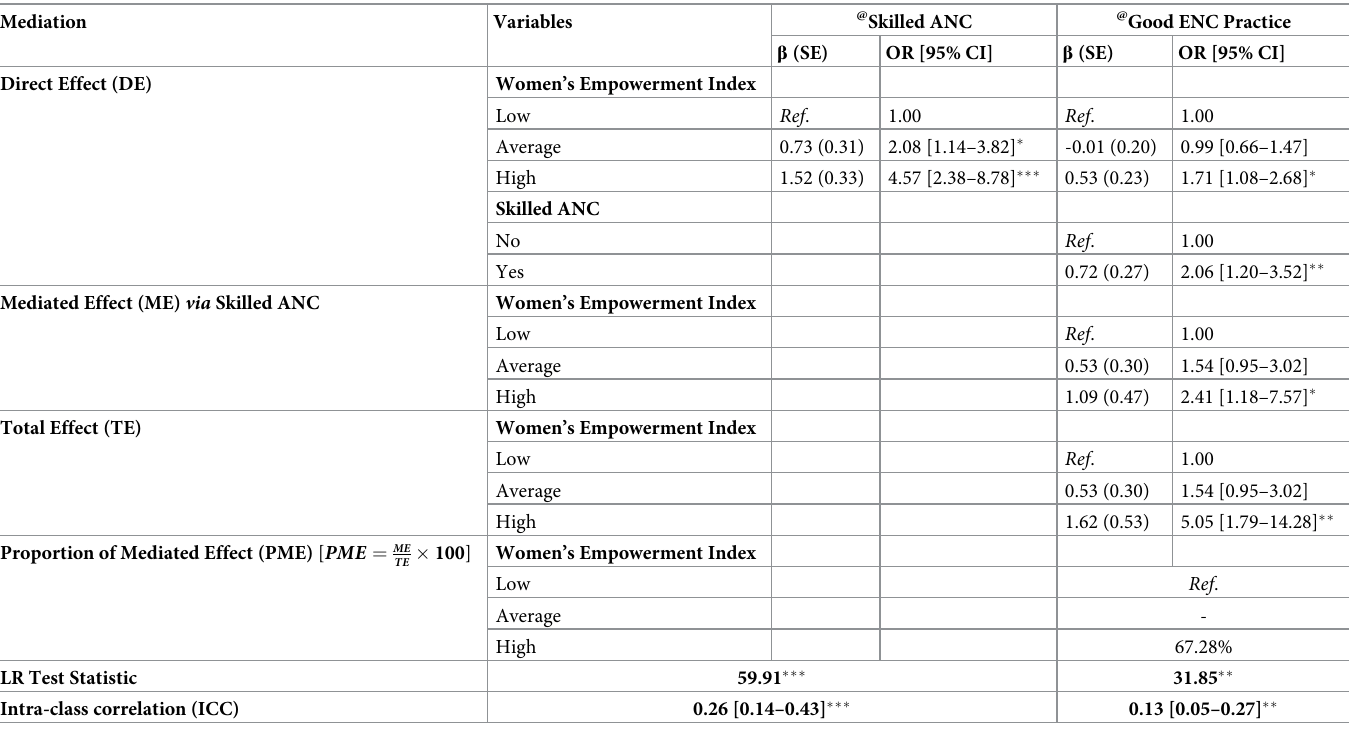
Table 3. Mediation results obtained from structural equation modeling using BDHS, 2017–18